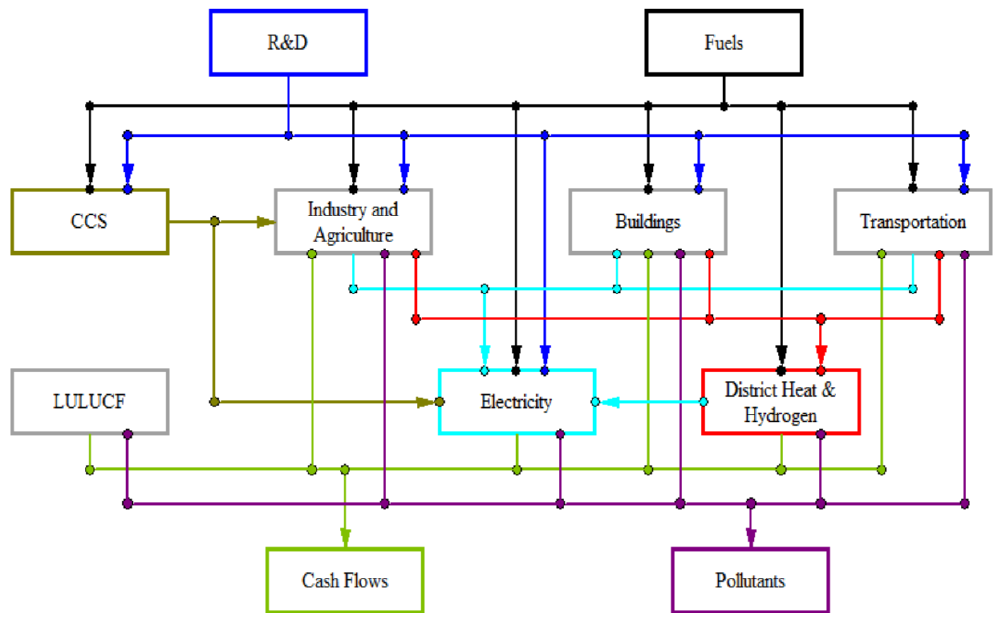
Figure 1. Overview of EPS model.